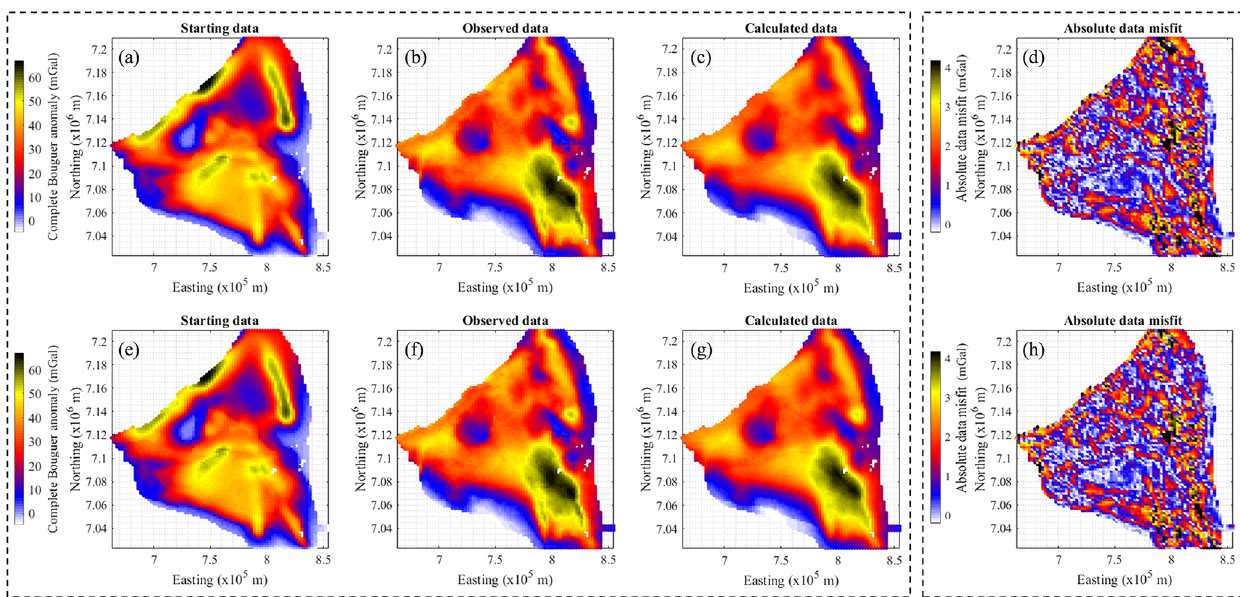
Figure A1. Comparison of input and output geophysical data. Panels (a) and (e) show data calculated from the prior model, (b) and (f) input measurements, (c) and (g) data calculated from the inverted model, and (d) and (f) the absolute value of the difference of the misfit between the observed and calculated data. Panels (a–d) (i.e. first line) and (e–h) (i.e. second line) correspond to the non-conditioned and conditioned cases,